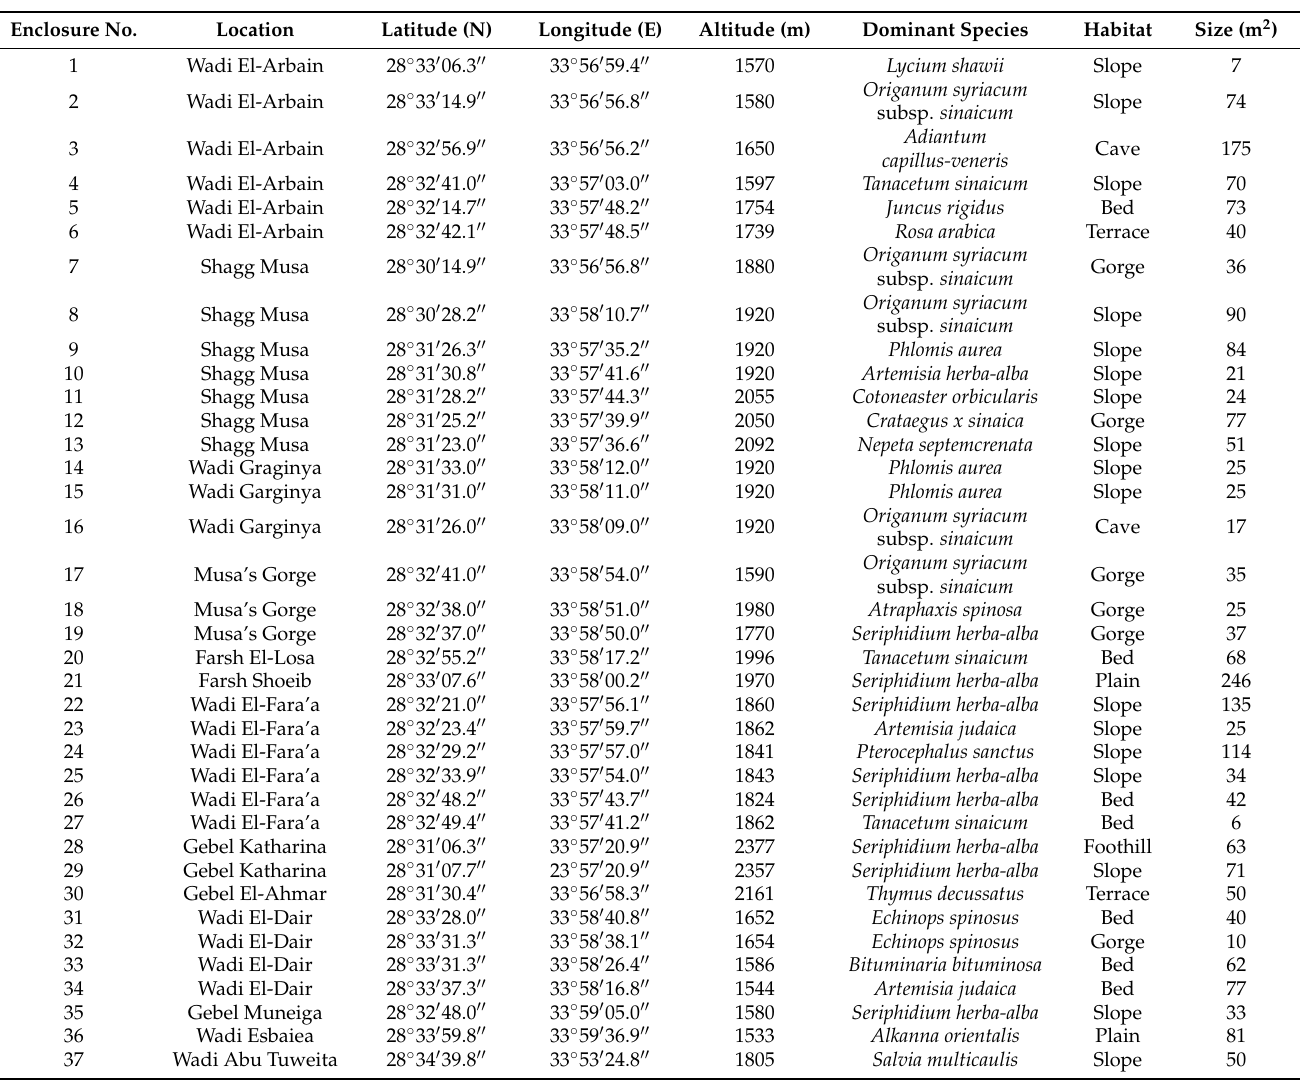
Table 1. Characteristics of the 37 enclosures in the South Sinai mountainous region (Saint Katherine, Egypt). Enclosure